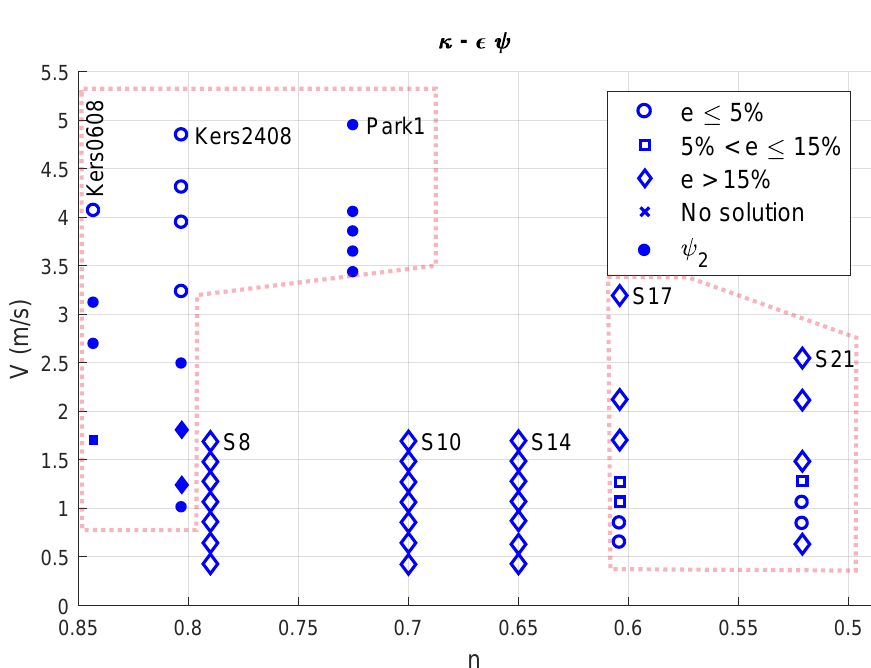
Figure 7. Error with the κ − (cid:101) model with ψ 1 (or ψ 2 , filled